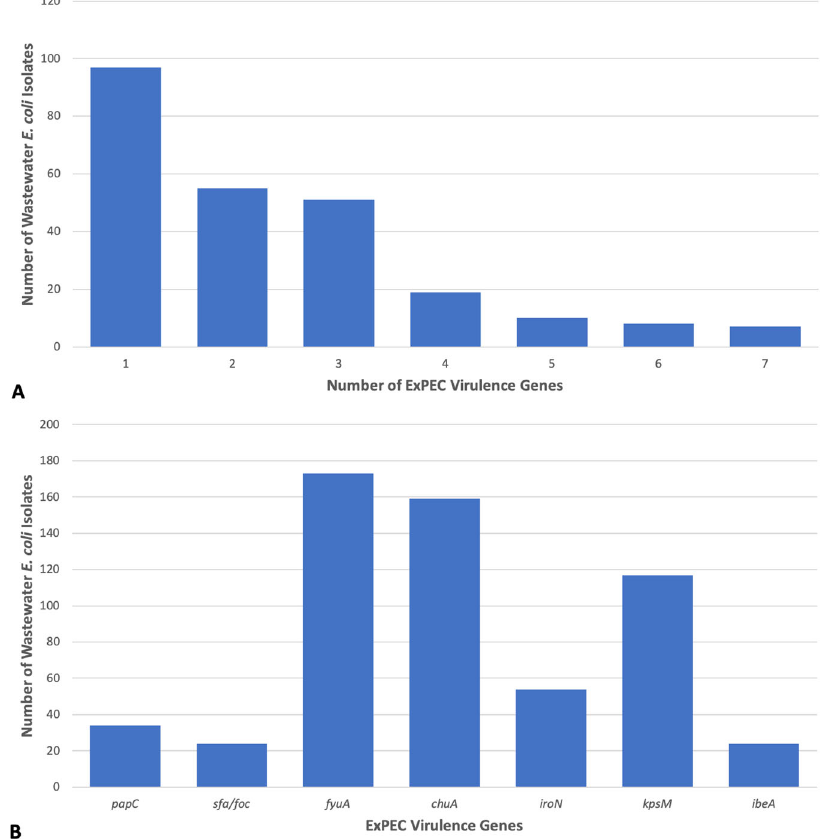
Fig. 1 ExPEC virulence marker screening panel results. Number A of ExPEC virulence genes harbored by each wastewater E. coli isolate and B their frequency across all wastewater E. coli isolates as determined by genetic screening with ExPEC PCR marker panel and targeted gene identi fi cation in the genome sequences of the wastewater E. coli